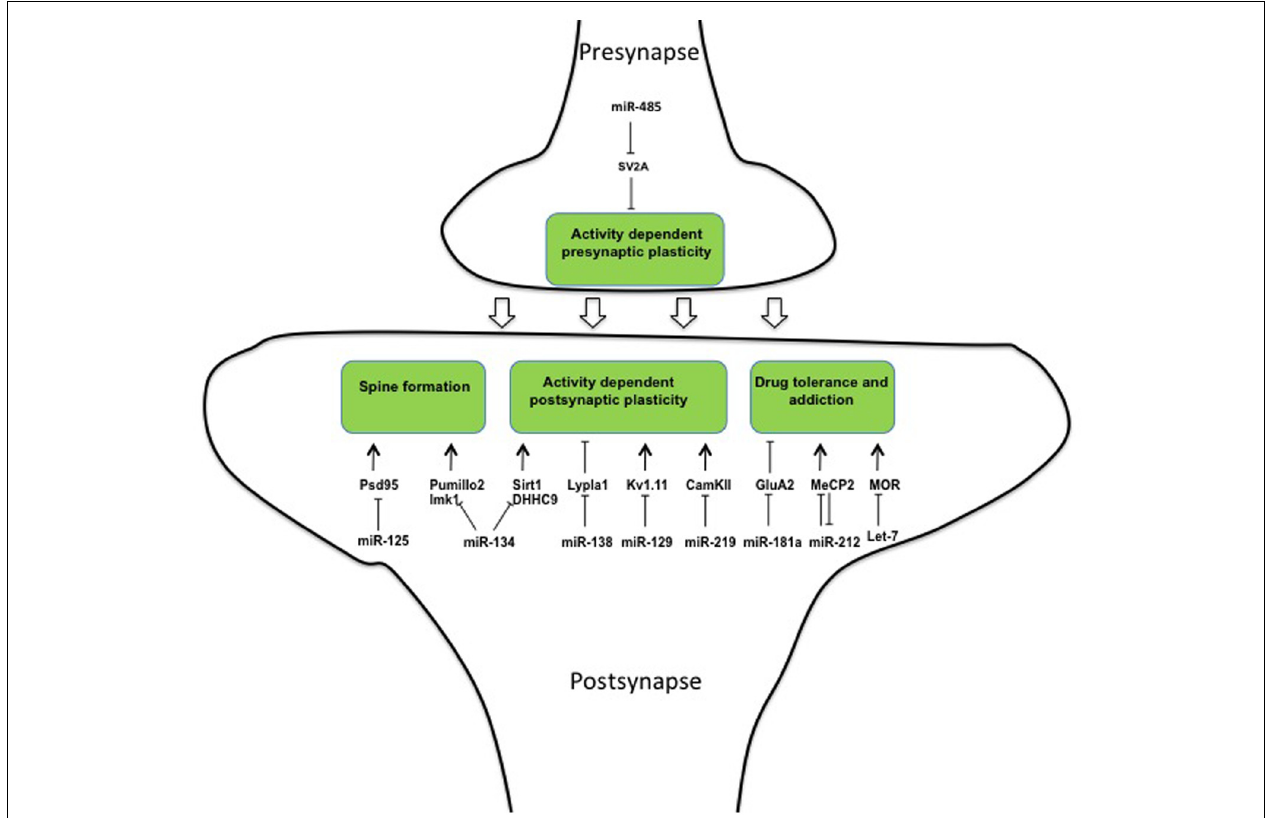
FIGURE 2 | MicroRNAs regulate different aspects of synapse formation, stabilization, and